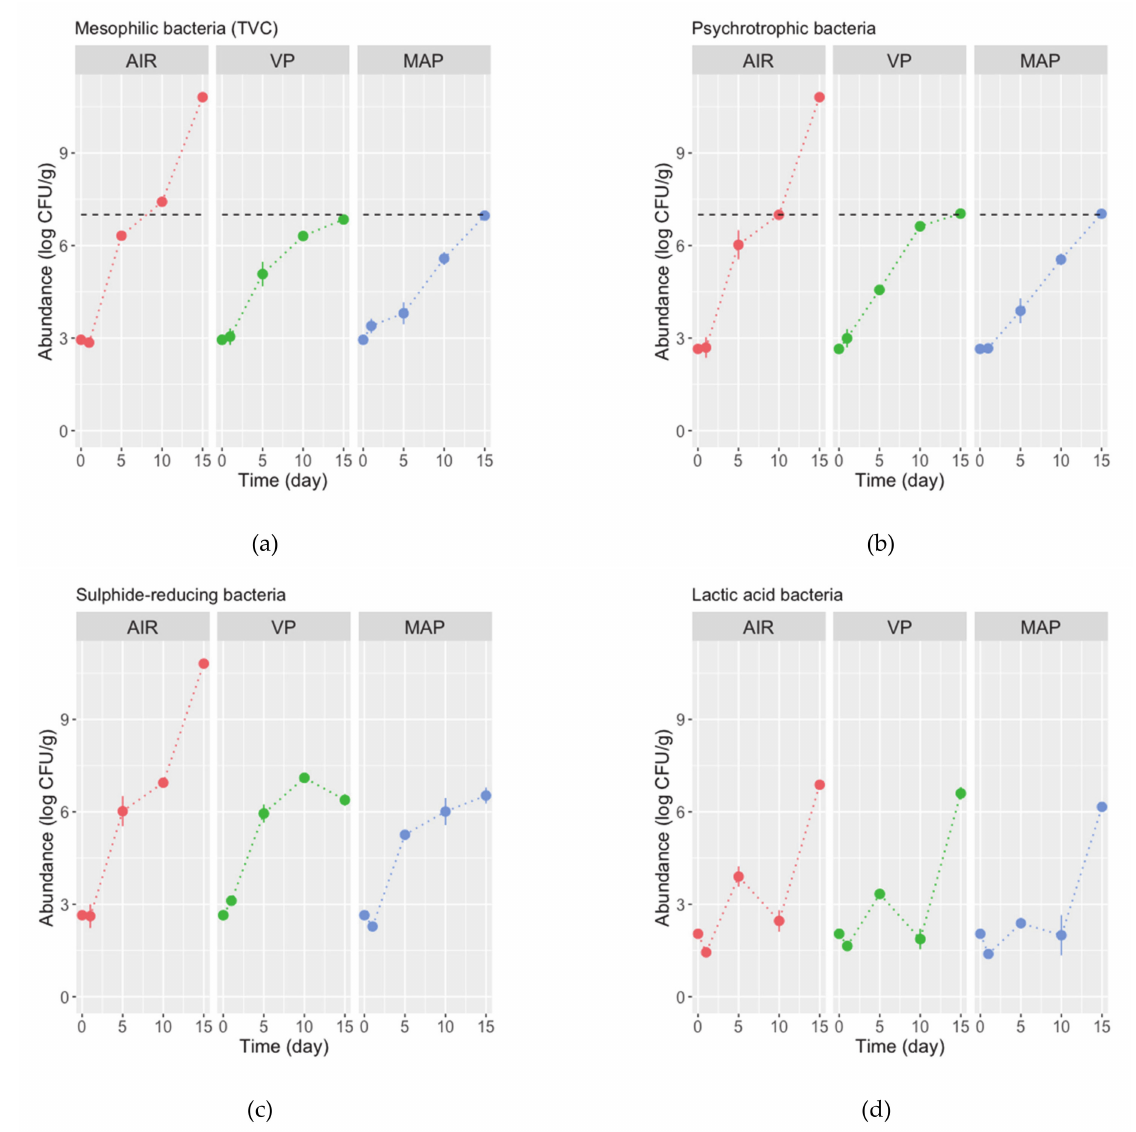
Figure 3. Changes in abundance of microbiota, ( a ) mesophilic, ( b ) psichrotrophic, ( c ) sulphide-reducing and ( d ) lactic acid bacteria, in fillets of triggerfish packed in air (AIR), vacuum (VP), and modified atmosphere (MAP) stored refrigerated for 15 days. Values are means of n = 2 fillets and whiskers represent the standard-error (SE). Horizontal dashed line in ( a ) represent the limit proposed by ICMSF